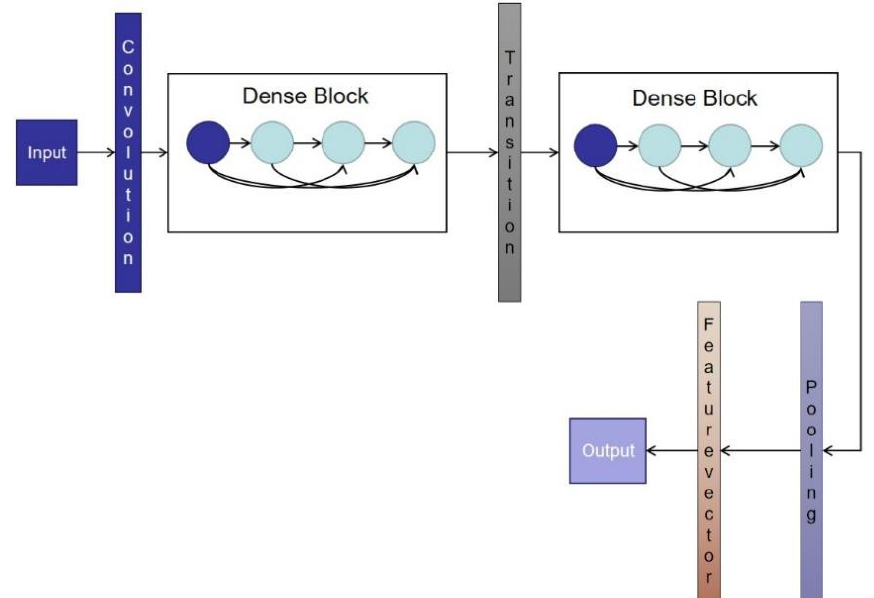
Dense blocks: Figure 4 shows the three-layer dense block model. Compared with Figure 3. Basic structure of DenseNet.